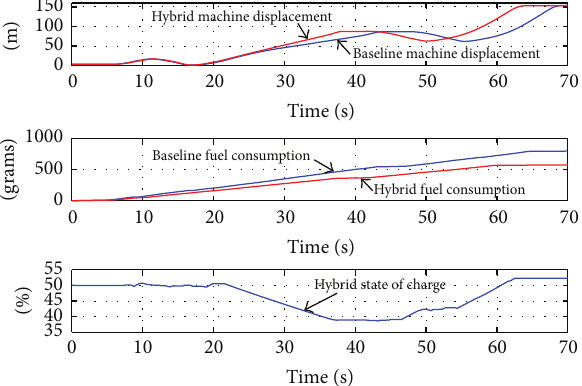
Figure 14: ATL hybrid versus baseline.